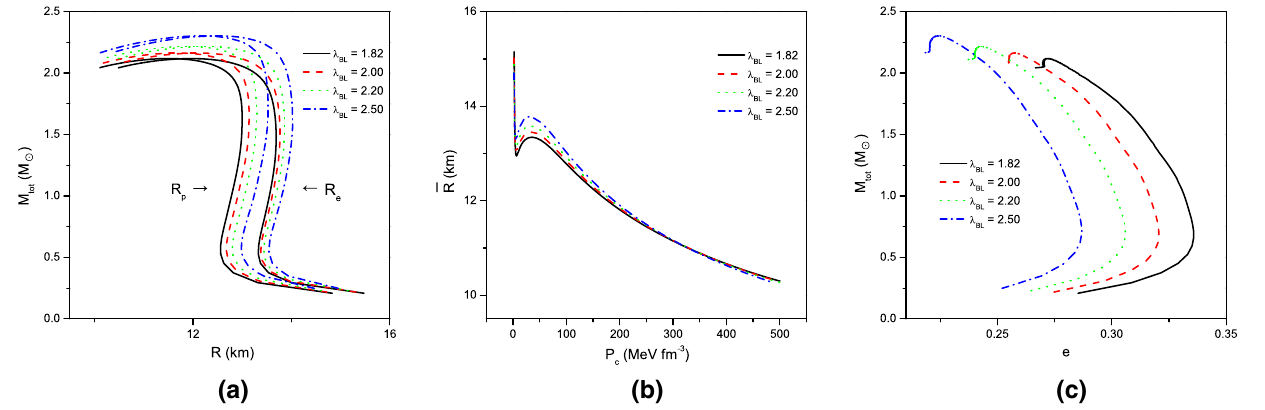
Fig. 3 Impact on anisotropic pressure on the star’s radius. a The rela- tion between radius and total mass. We label polar radius and equatorial radius as R p and R e , respectively. The appearance of R p and R e shows that the star is deformed. The points where R p and R e overlap indicate no deformation at certain masses. b The relation between the pressure at the center and the average radius of the star. Here we can see that